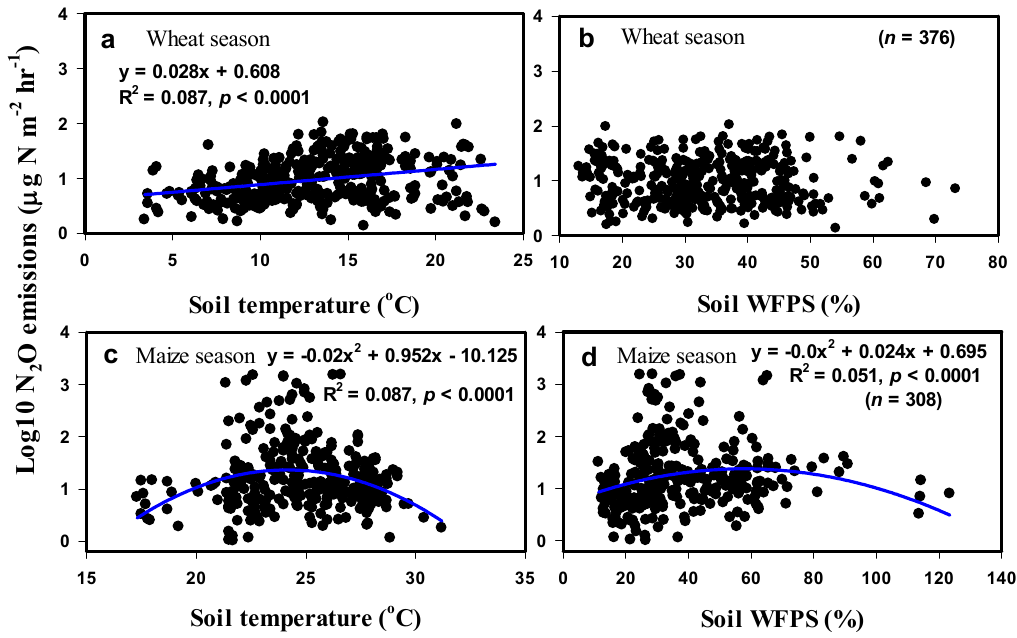
Figure 8. Relationships between N 2 O emissions, soil temperature, and soil water-filled pore space (WFPS) in the wheat season ( a and b ) and in the maize season ( c and d ) for the wheat and the maize seasons across the four treatments over the two-year period from 2016–2018.